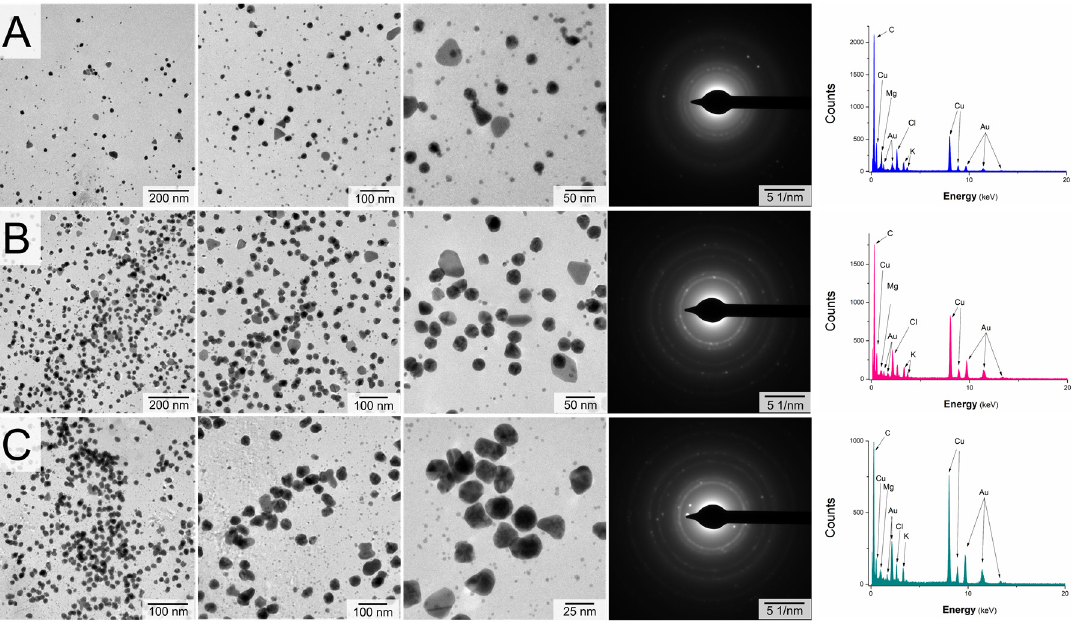
Figure 3. Transmission electron microscopy (TEM) photomicrographs, selected area X-ray diffraction (SAED) patterns and energy dispersive X-ray scattering (EDX) spectra of AuNPs obtained using ( A ) untreated; ( B ) flowing liquid anode (FLA)-dc-APGD-activated; or ( C ) flowing liquid cathode (FLC)-dc-APGD-activated aqueous G. biloba leaves extracts. The concentration of Au (III) ions used for the synthesis of biogenic AuNPs was 500 mg L − 1 .